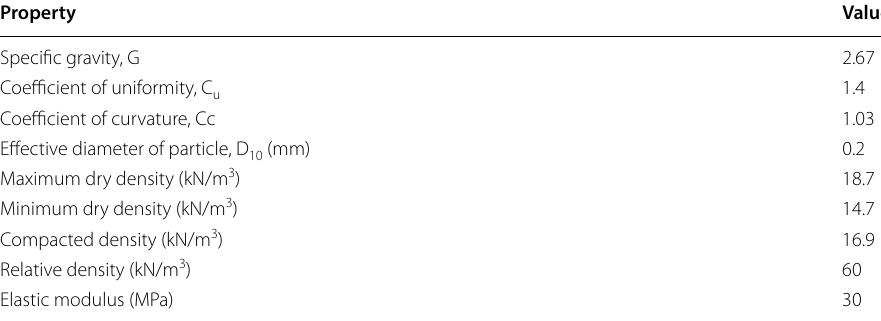
Table 1 Properties of sand used Property